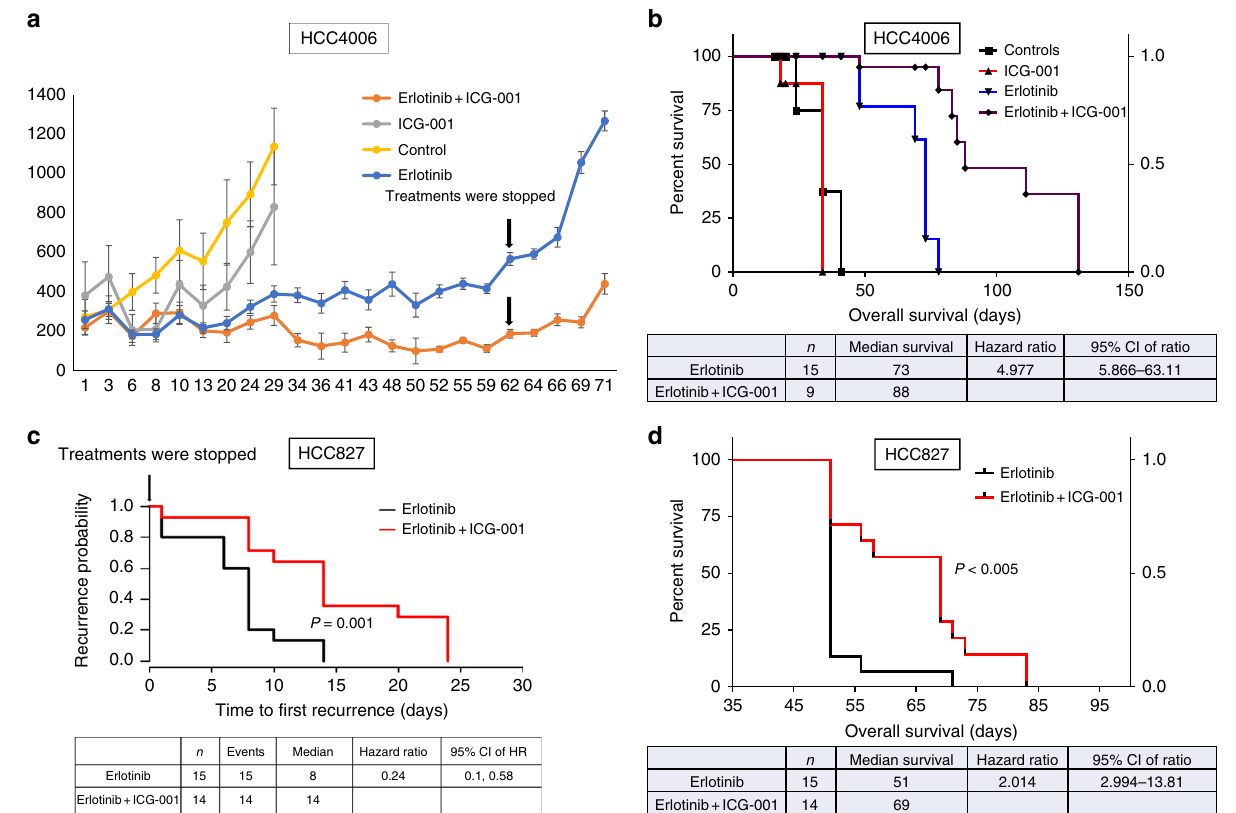
Fig. 9 EGFR TKI treatment in combination with β -catenin inhibition strongly attenuates tumor onset in EGFR mutant NSCLC in vivo. a Human HCC4006 subcutaneous xenografts treated with erlotinib (50 mg/kg/day) or ICG-001 (150 mg/kg/day) alone or in combination for 5 days in a week for 9 weeks. b Overall survival analysis of HCC4006 xenograft mice that were treated with erlotinib or ICG-001 alone or in combination ( P = 0.0001). c Human HCC827 subcutaneous xenografts were grown in mice that were treated with erlotinib (50 mg/kg/day) alone or in combination with ICG-001 (150 mg/kg/day) for 5 days a week for 3 weeks. After treatments were stopped, tumor recurrence was compared between the two groups. d Overall survival analysis of HCC827 xenograft mice that were treated with erlotinib alone or in combination with ICG-001 ( P = 0.0001) for 21 days. Overall survival was determined after treatments were stopped. For ( a ) error bars represent